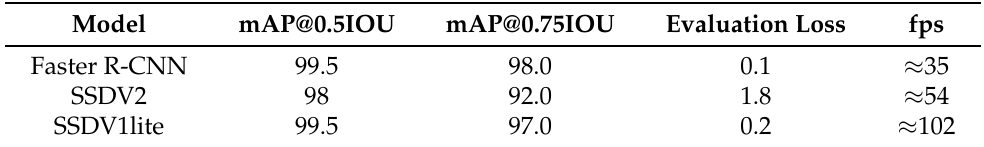
Table 3. Summarized mean average precision at 0.5 IoU and 0.75 IoU, evaluation loss, and frames per